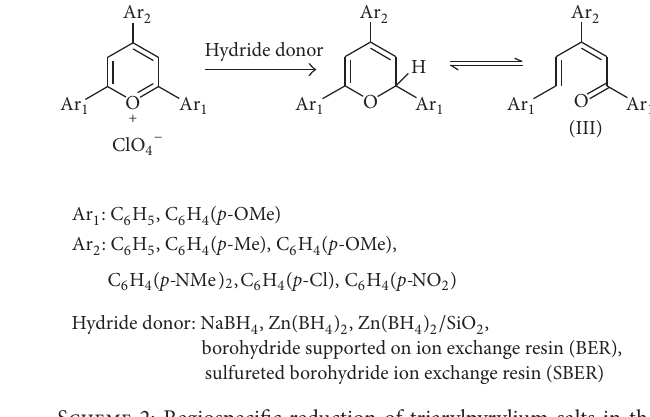
S 1: Reduction of trialkyl and triphenylpyrylium salts in the . presence of NaBH 4